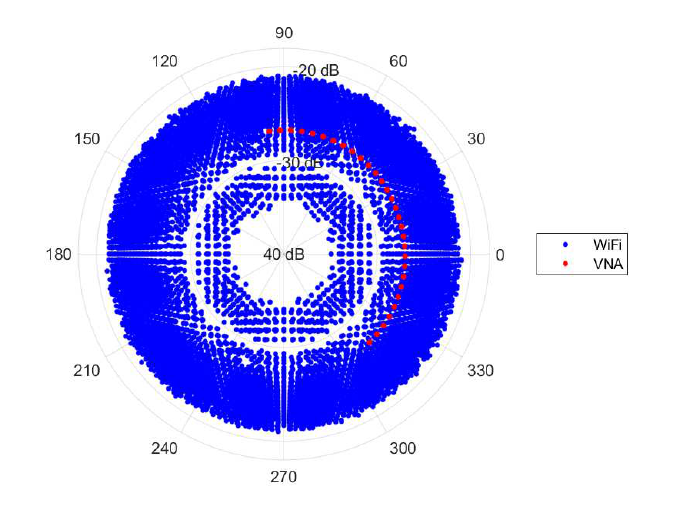
Figure 3. 2000 snapshots of the phase of Wi-Fi channel state information (CSI), blue dots, and the phase of a channel measured by vector network analyzer (VNA) , red dots, under the same b2b configuration plotted in polar